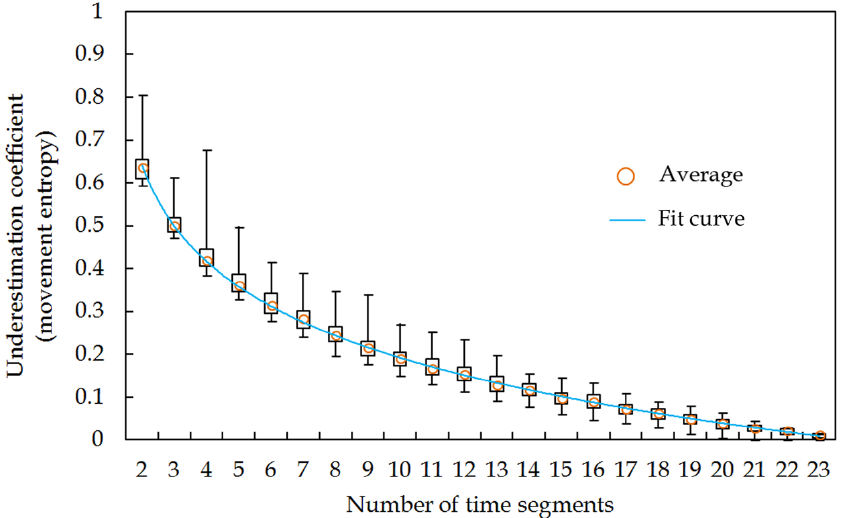
Figure 11. Distribution of aggregated underestimation coefficients for estimating movement entropy using different numbers of time segments.